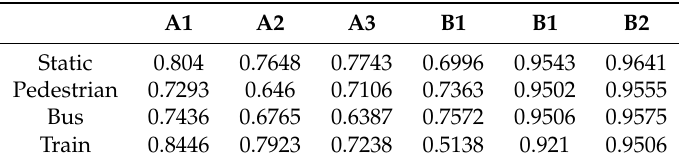
Table 1. Playback stability.